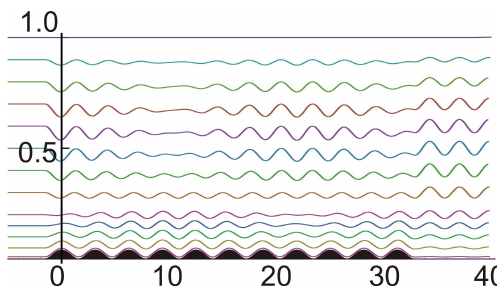
Fig. 3. Isolated wave packets over the